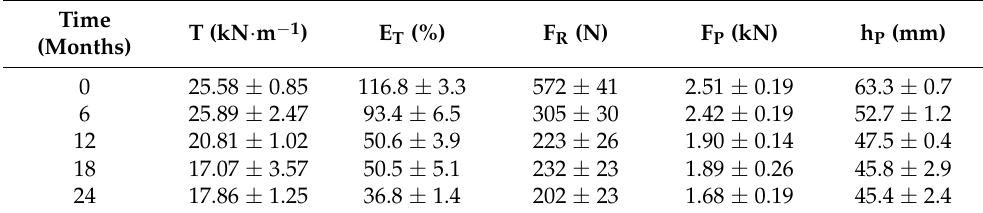
Table 5. Mechanical properties of GT500 before and after the field weathering